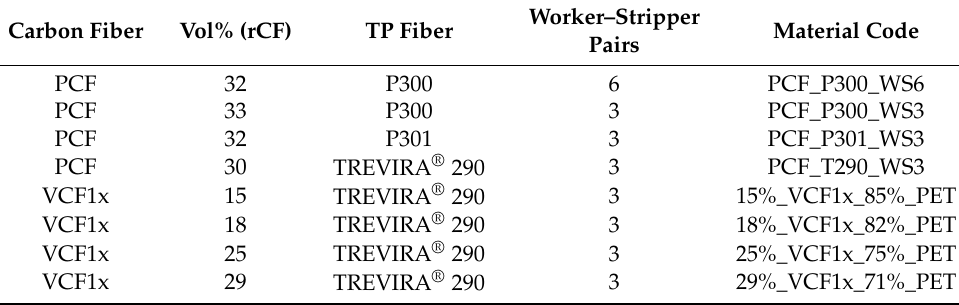
Table 4. Parameters of hybrid nonwovens for the hot-pressing